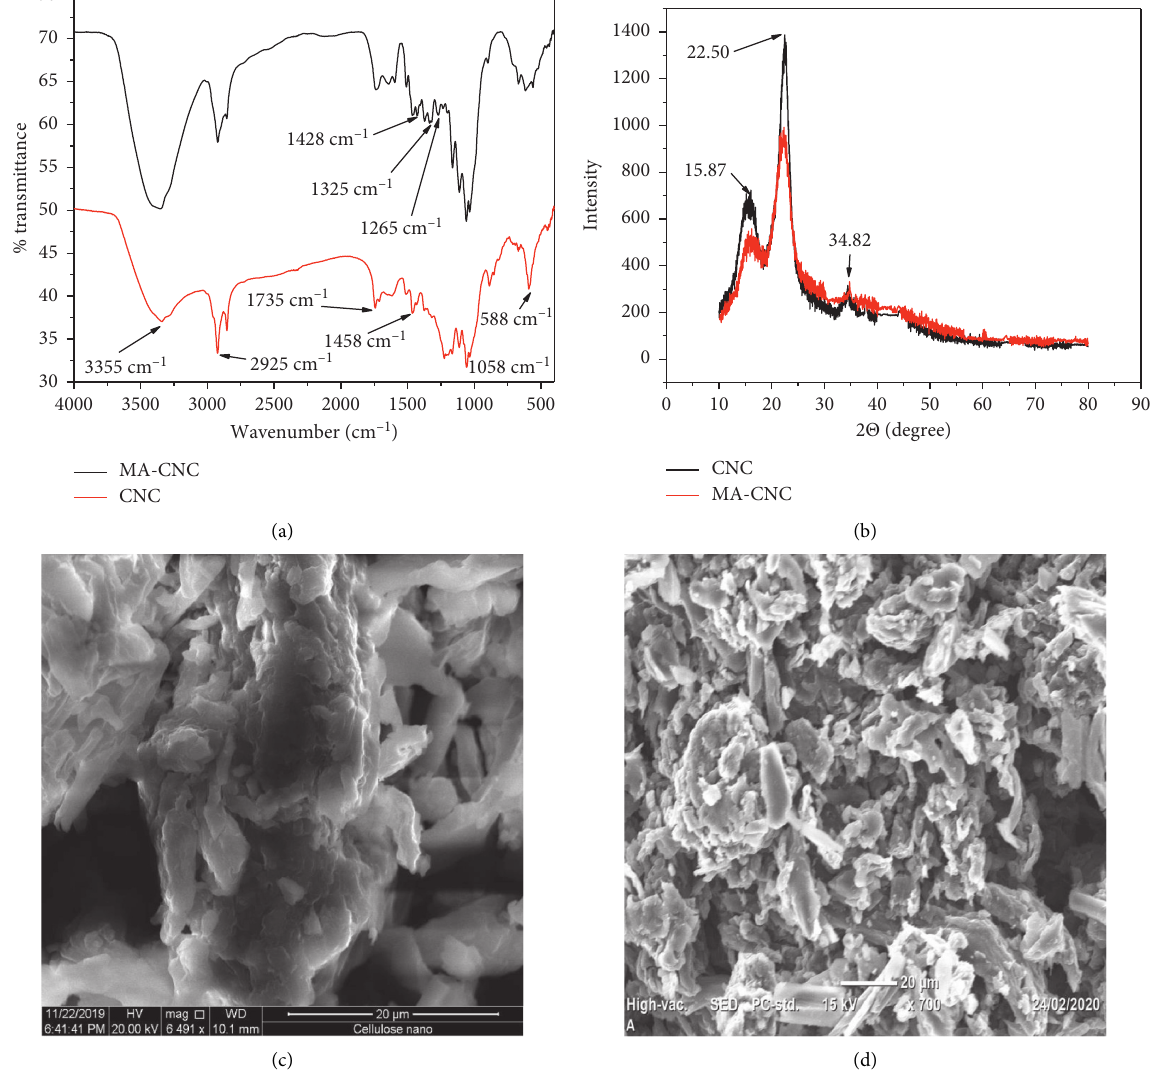
Figure 3: (a) FTIR spectra, (b) XRD pattern, and (c, d) SEM images of CNC and MA-CNC sorbents,